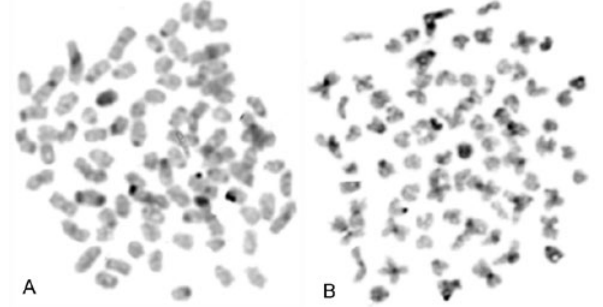
Figure 3. C-banded karyotype of Abant trout Salmo t. abanticus. Constitutive heterochromatin at the centromeres and arms of most of the